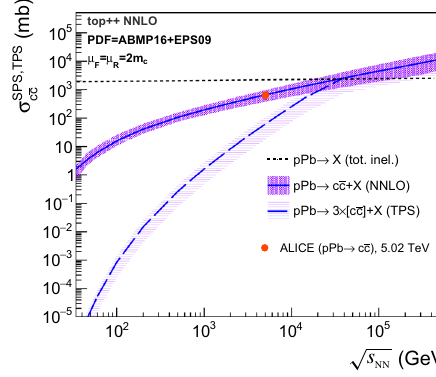
Fig. 1 Charm (left) and bottom (right) cross sections in pPb colli- sions as a function of nucleon-nucleon c.m. energy, in single-parton (solid band) and triple-parton (dashed band) scatterings, compared to the total inelastic pPb cross section (dotted line). Bands around curves